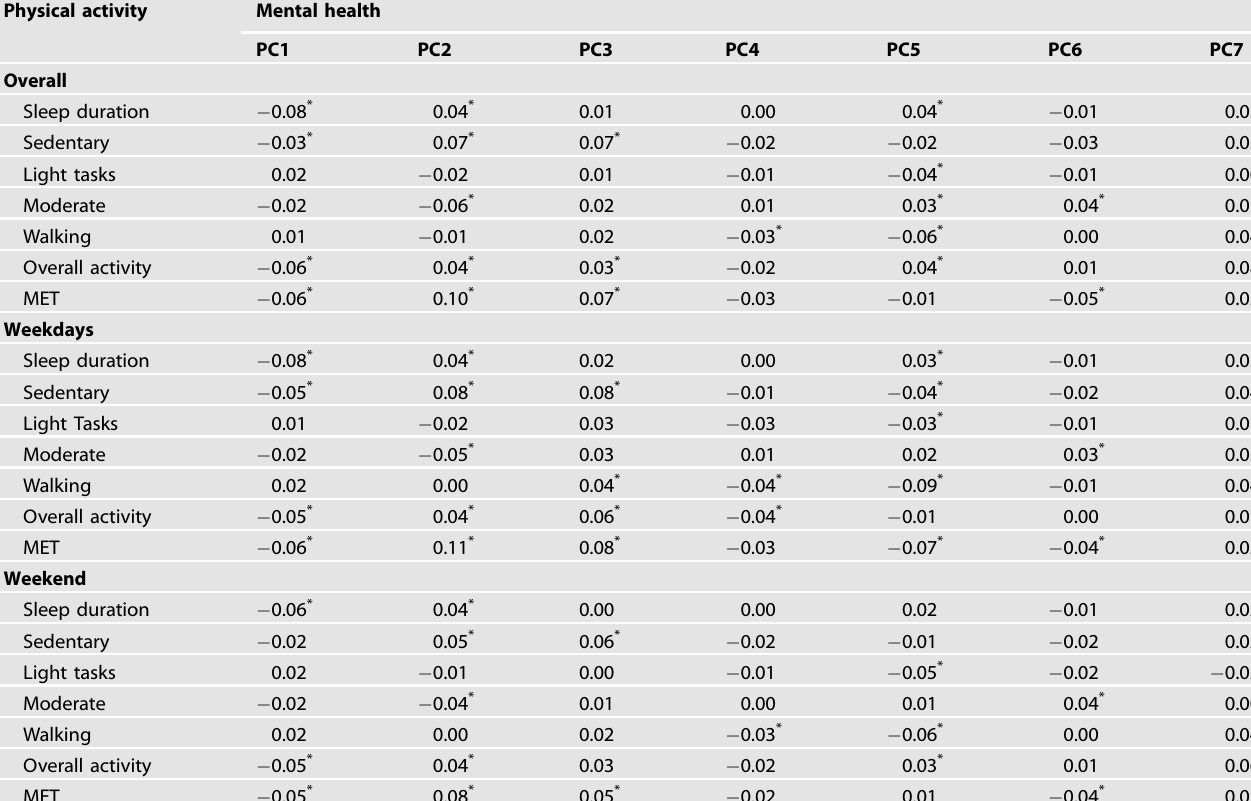
Table 1. Correlations between mental health and physical activity